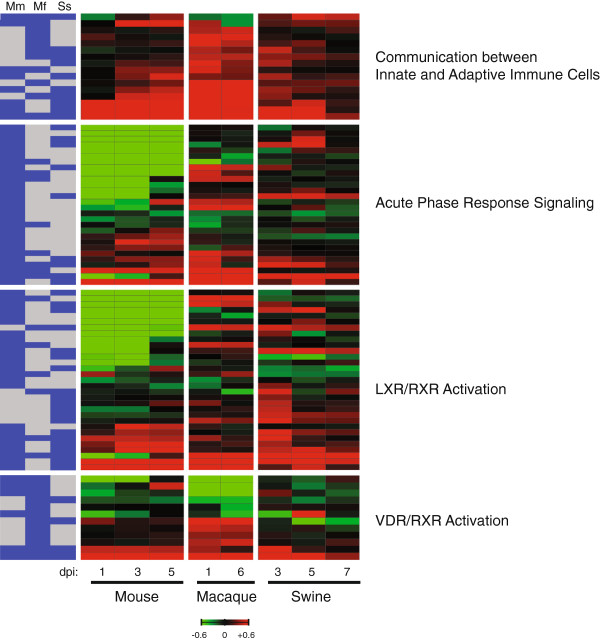
Immune genes exhibit unique expression profiles in mice, macaques, and swine infected with CA04 virus. Average log10(ratio) expression of DE genes induced by CA04 virus. In mice and swine, infected lung gene expression is referenced to specie-matched mock at each time point. In macaques, infected lung gene expression is relative to an uninfected lung reference pool at each time point. Red indicates expression was increased relative to the control reference and green indicates that expression was decreased relative to the control reference. Saturation is 4-fold. There are a total of 16 DE genes represented for Communication between Innate and Adaptive Immune Cells, 28 DE genes represented for Acute Phase Response Signaling, 31 DE genes represented for LXR/RXR Activation, and 12 DE genes represented for VDR/RXR Activation. The association of each DE gene within a given species for each of the represented Canonical Pathways is shown on the left; blue denotes differential expression and gray denotes no differential expression. The following abbreviations are used: Mm, Mus musculus (mouse); Mf, Macaca fascicularis (macaque); and Ss, Sus scrofa (swine).